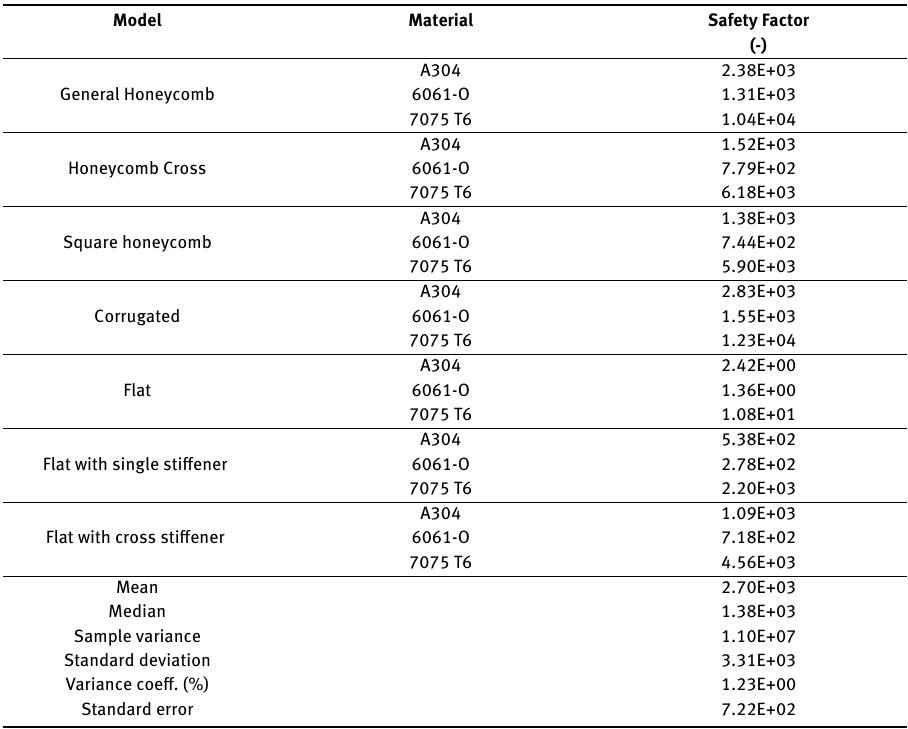
Table 6: Summary of the safety factor